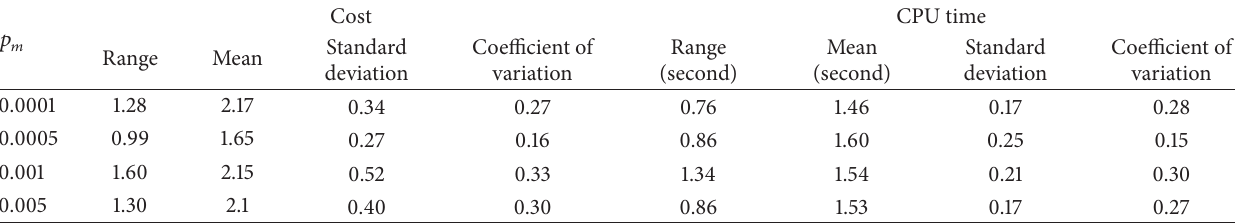
Table 1: The results with different 𝑝 𝑚 (cost: million yuan, CPU time: second). Cost CPU time 𝑝 𝑚